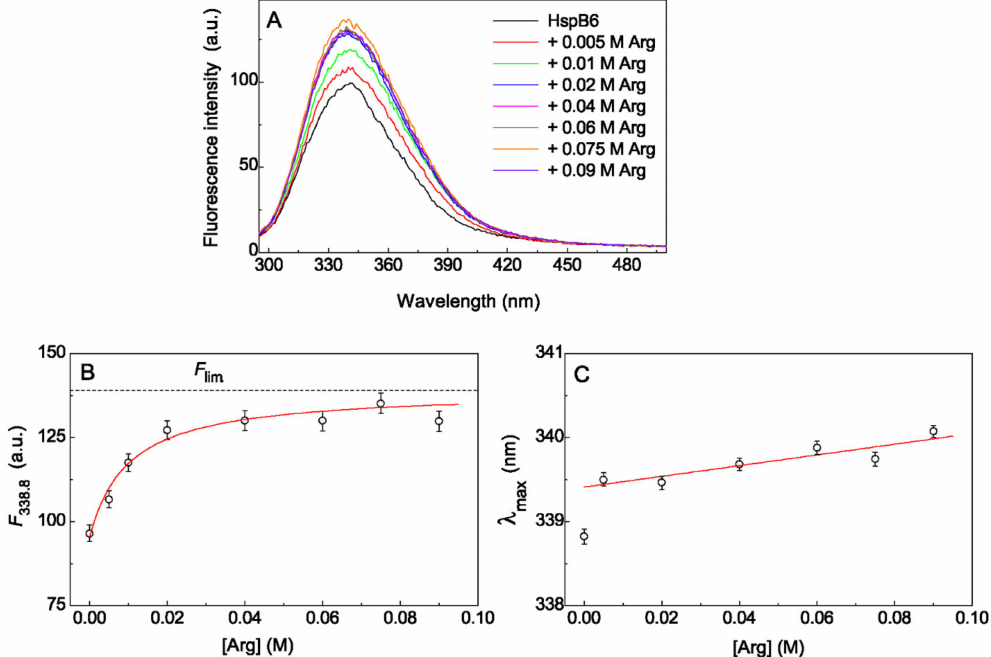
Figure 5. The e ff ect of Arg on tryptophan fluorescence of HspB6. ( A ) The tryptophan fluorescence spectra of HspB6 (0.32 mg / mL) in 0.03 M Hepes-bu ff er, containing 0.5 mM dithiothreitol (DTT), and in the presence of increasing concentrations of Arg from 0 to 0.09 M. The spectra were obtained at 25 ◦ C, excitation wavelength of 292 nm and constant ionic strength of 0.15 M. ( B ) The dependence of fluorescence intensity on Arg concentration at λ = 338.8 nm. Points are the experimental data. The solid curve was calculated using Equation (4) at K diss = 0.01 M, F 0 = 95.6 and F lim = 139. The horizontal dash line corresponds to F lim value. ( C ) The dependence of Trp emission maximum ( λ max ) on Arg